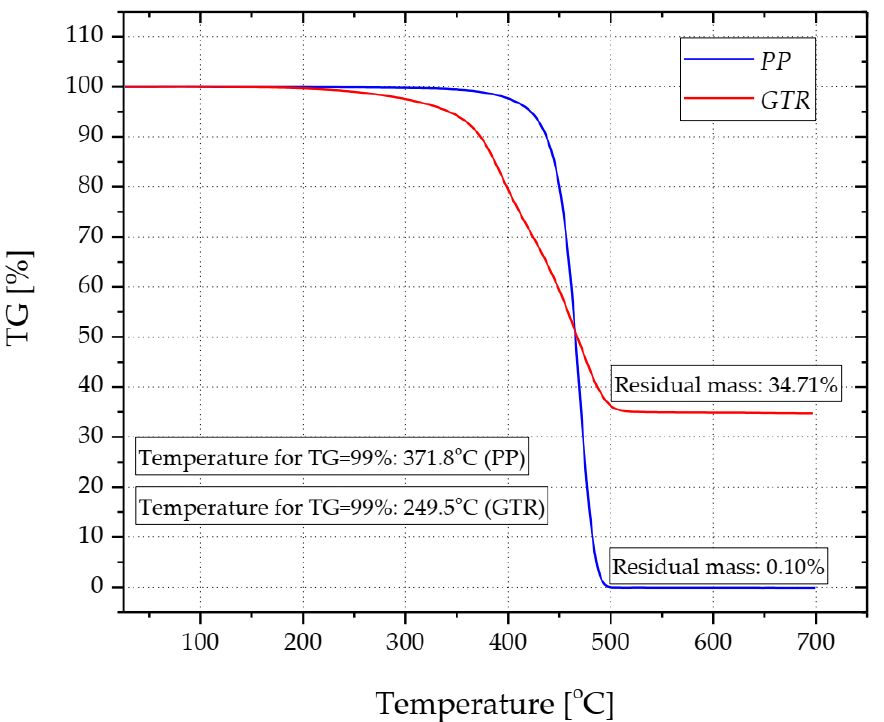
Figure 3. Thermal stability of PP and GTR determined by TG 209 Libra (Netzsch, Selb, Germany). Seven polypropylene compositions containing from 30 to 90 wt.% GTR were prepared (first series). The second series included PP/GTR compounds, which were modified with 2.5-dimethyl-2.5-di-(tert-butylperoxy)-hexane to the amount of 1.5 wt.%. Moreover, copoly-